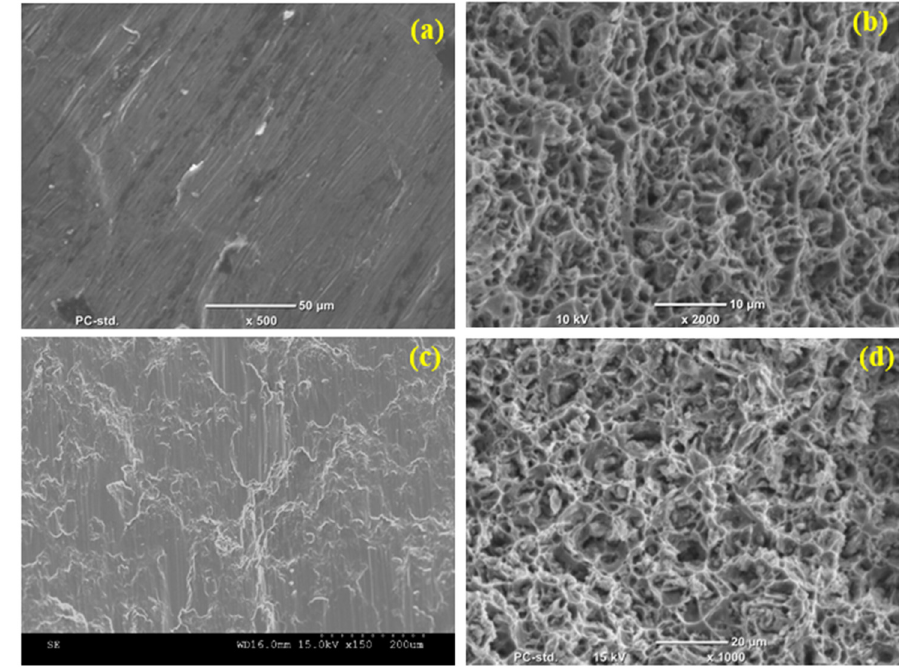
Figure 5. Compression ( a , c ) and tensile ( b , d ) fractography images of pure Al and Al-1.5 NiTi nanocomposite.